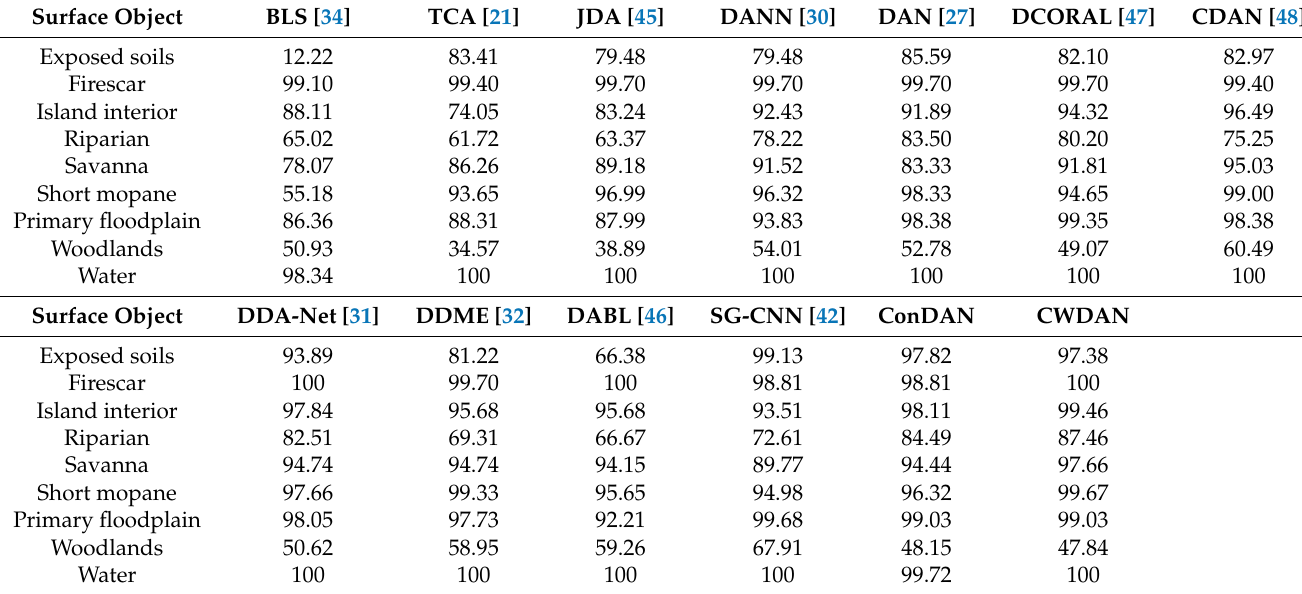
Table 4. Comparison of classification performance